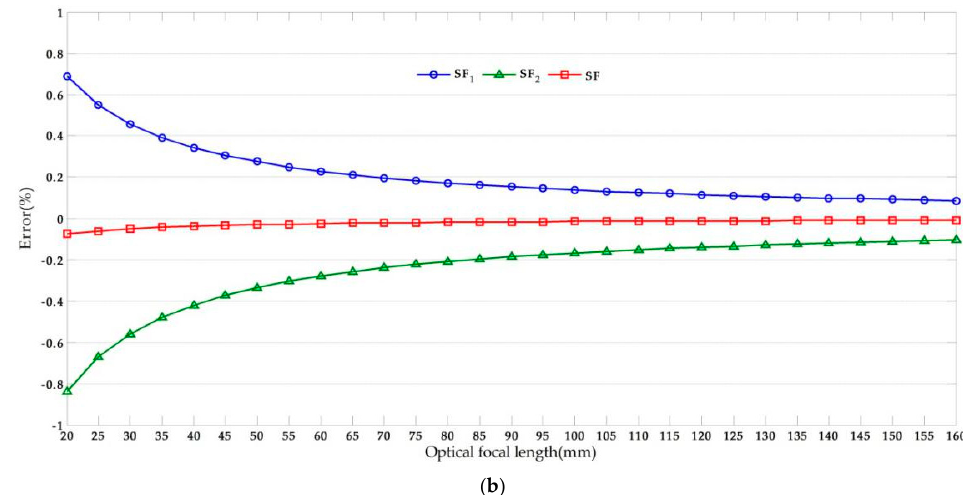
Figure 7. Error analysis results: ( a ) effects of optical axis tilt angle ( f = 50); ( b ) effects of optical focal length ( θ = 10°).